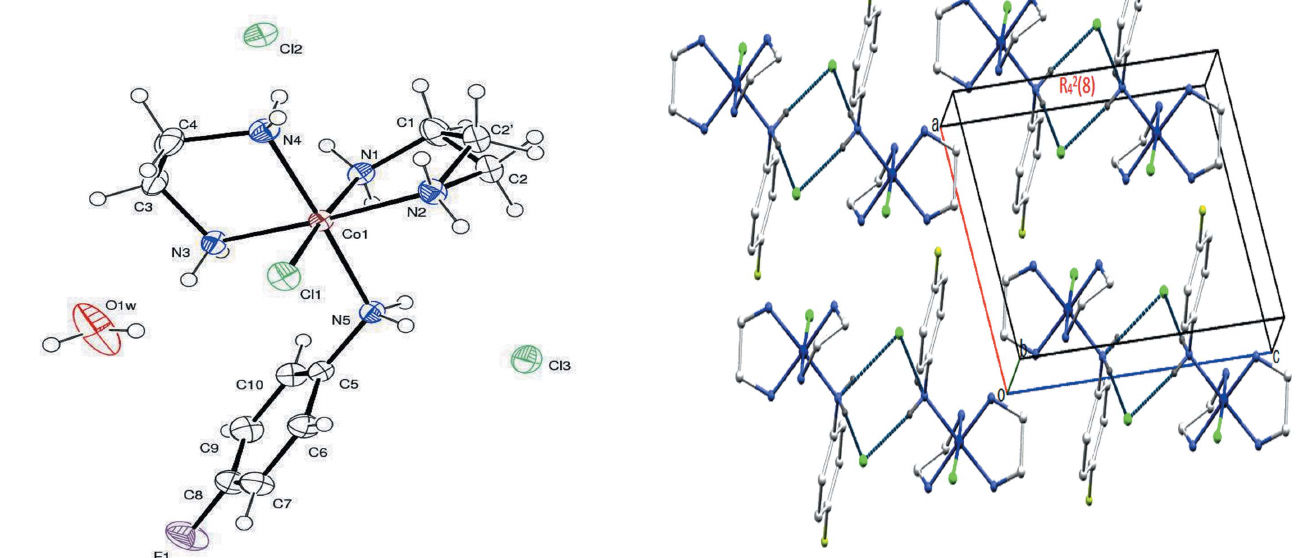
Figure 3 Representative of all other hydrogen-bonding interactions, N—H (cid:2)(cid:2)(cid:2) Cl hydrogen bonds are shown (dotted lines), generating an R 2